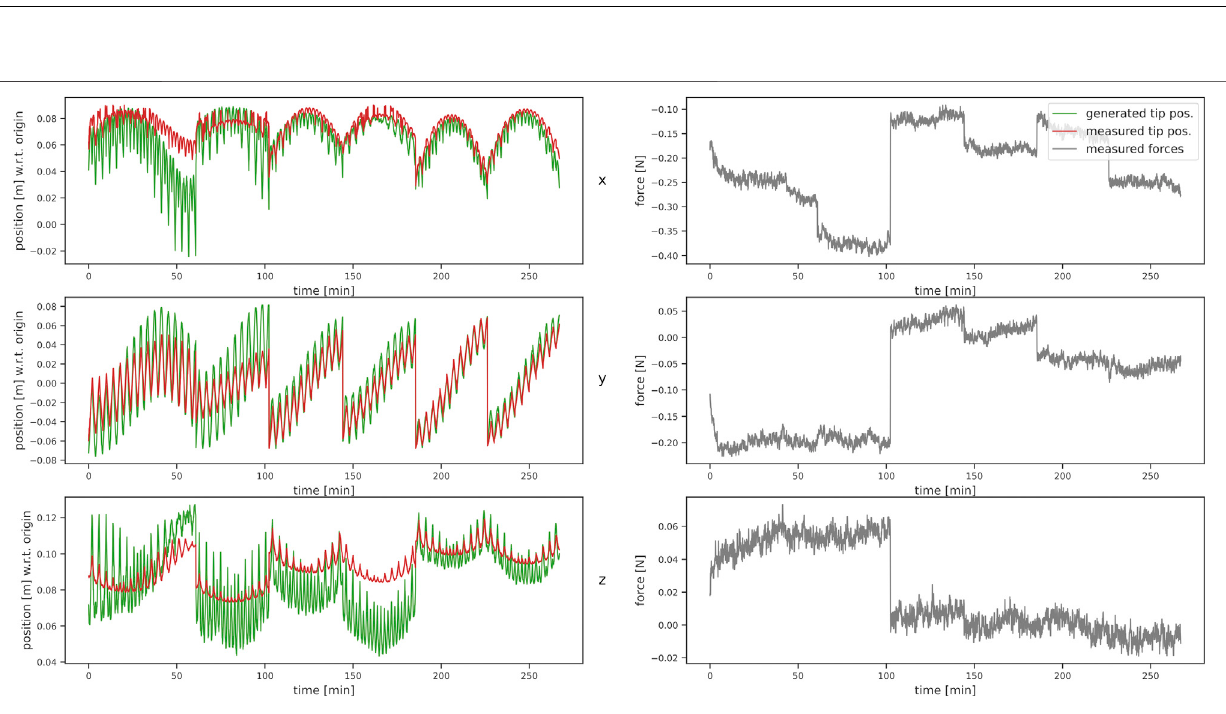
Frontiers in Robotics and AI |